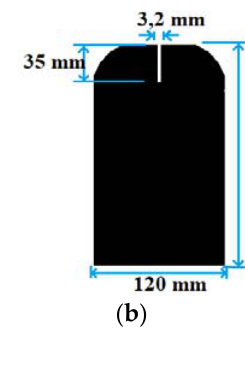
Figure 3. Designed model for the Inga Marginata bio ‐ inspired PMA antenna: ( a ) Patch dimensions; ( b ) Ground plane dimensions.